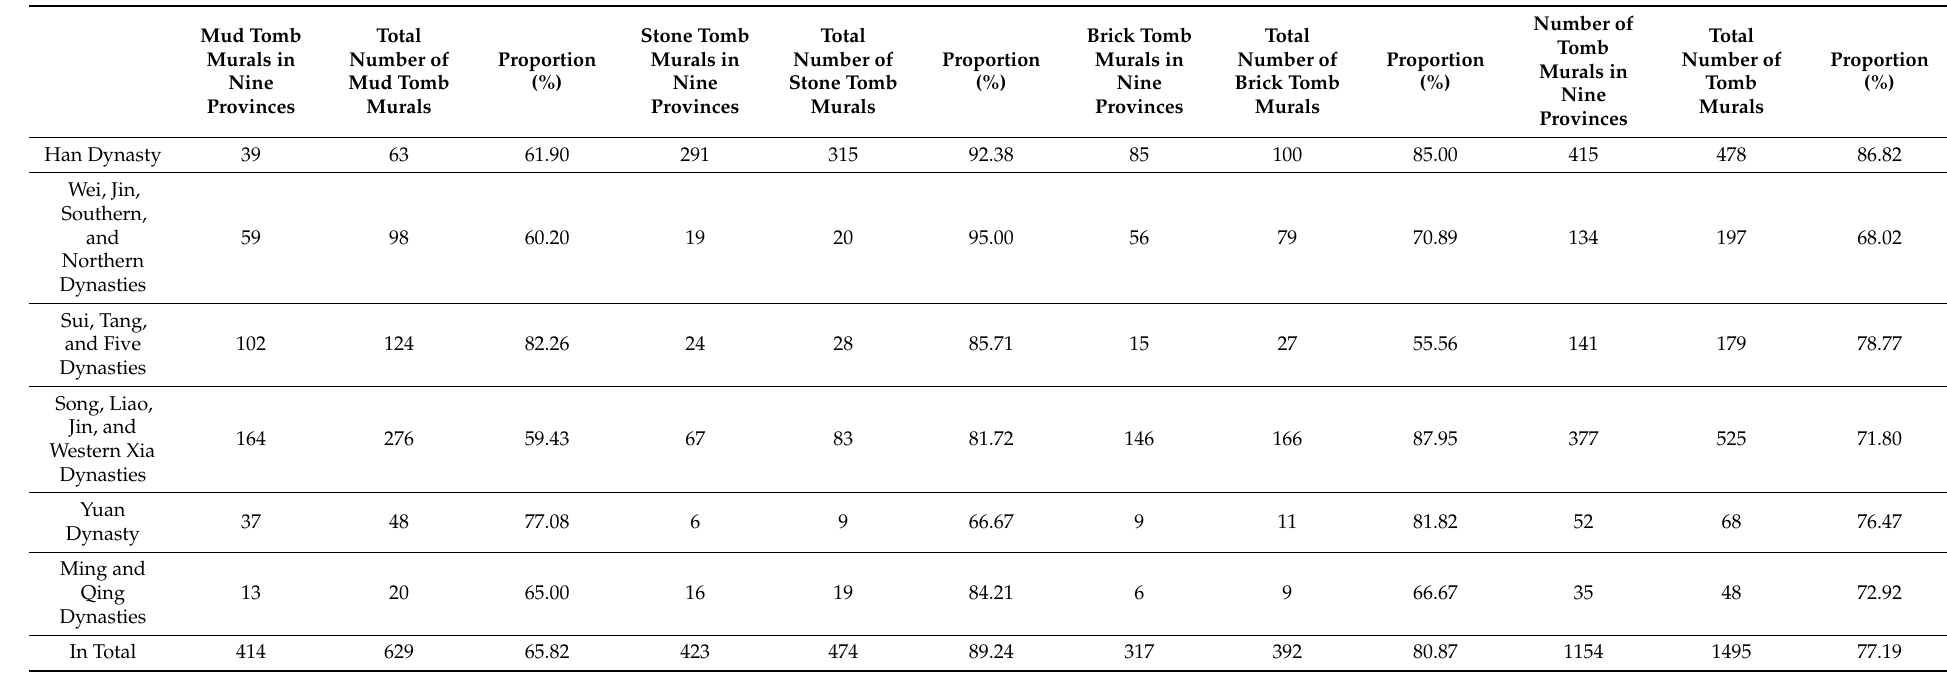
Table 4. Statistics of the proportion of the types of relic sites found in nine